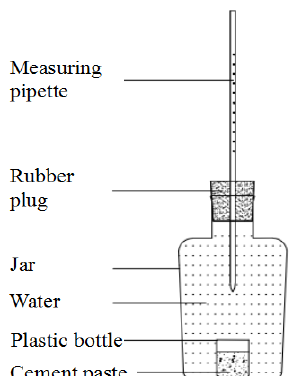
Figure 3. Chemical shrinkage device for the CSA cement paste.